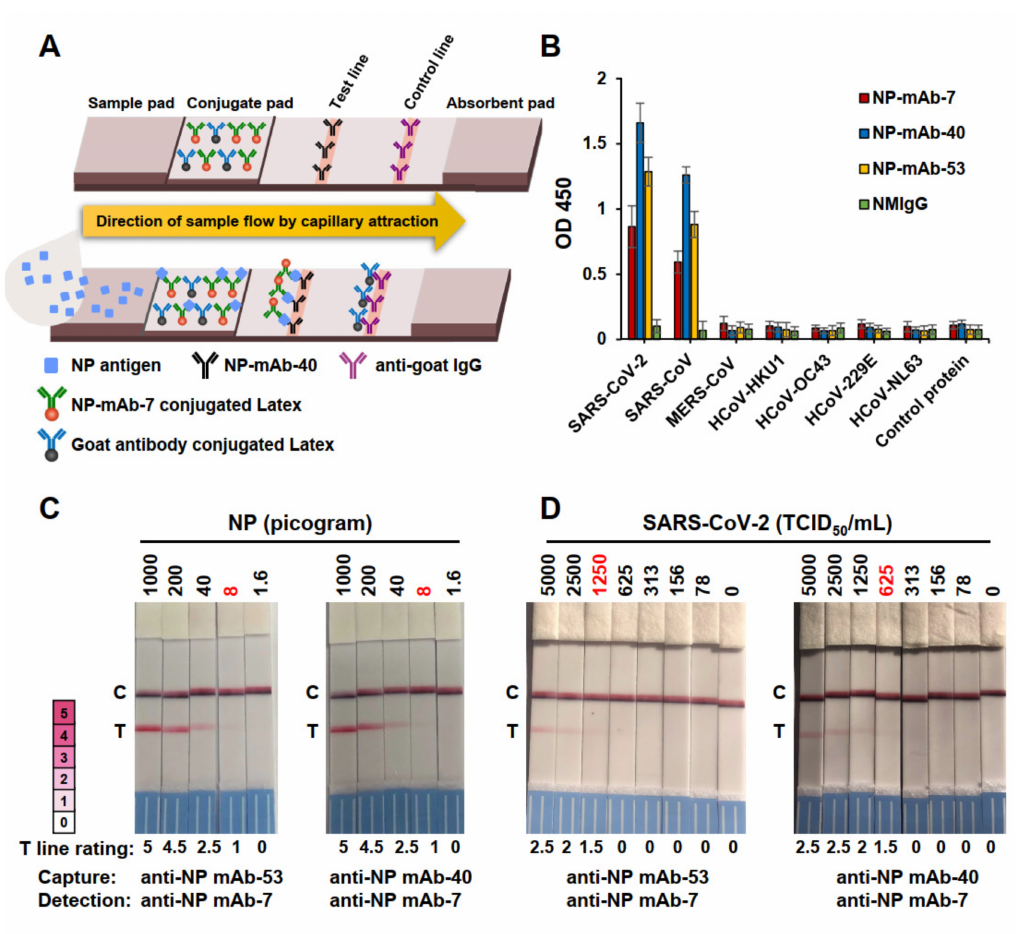
Figure 2. Detection limit of two LFIAs using different capture mAbs. ( A ) Schematic diagram of the lateral flow rapid test configuration. ( B ) Binding activities of anti-NP mAb-7, -40, and -53 to NPs from seven types of human coronaviruses (HCoV). Each recombinant NP-His was coated at the same concentration on the ELISA plates. Anti-NP mAbs were added at 100 ng/mL to the probe antigens. ( C ) SARS-CoV-2-infected Vero E6 cells were collected in a lysis buffer, and the NP concentration was determined by sandwich ELISA. The samples were diluted to given concentrations and analyzed by two antigen rapid tests with different capture mAbs. The rating chart showed an intensity range from 0 to 5 grading of the positive and negative results on the test line. A color intensity ≥ 0.5 was judged as a positive result. A color intensity < 0.5 was judged as a negative result. ( D ) Authentic SARS-CoV-2 virus concentrations ranging from 0 to 5000 TCID 50 /mL were used to detect the sensitivities of two antigen rapid tests. The numbers in red indicate the limits of detection